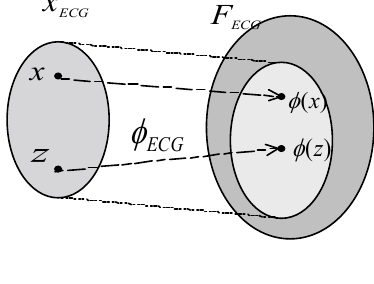
Figure 3 . “Kernel Trick” used for KPCA and KICA Kernel Principal Component Analysis